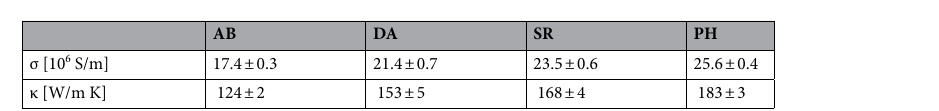
Table 2. Electrical conductivity (σ) and thermal conductivity (κ) of LPBF AlSi10Mg (AB, DA, SR, PH), measured at room temperature.